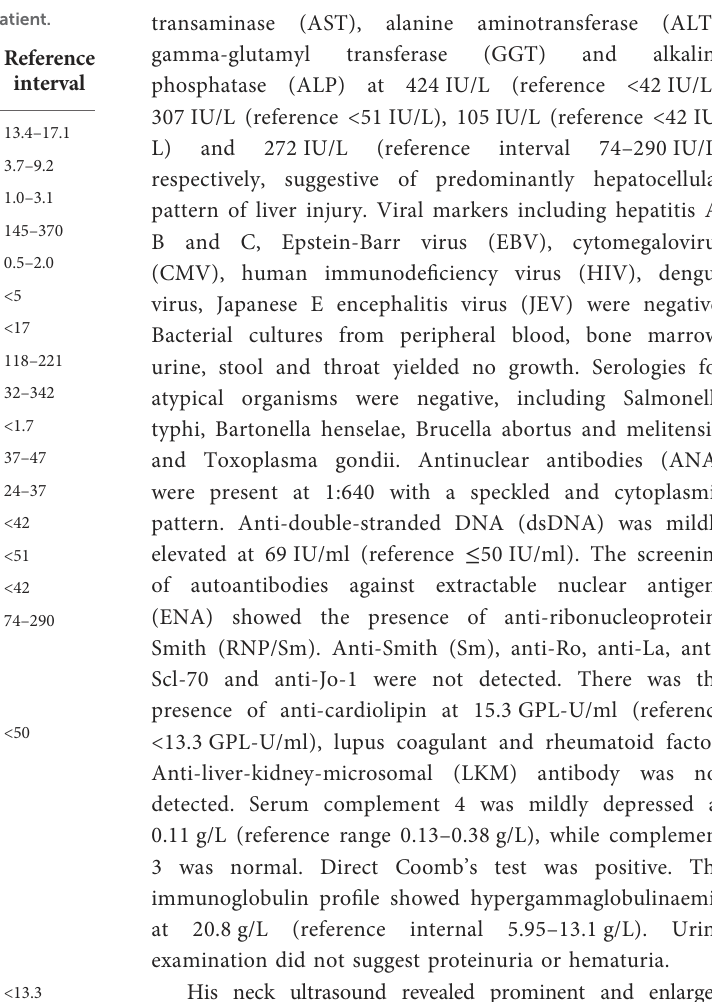
TABLE 1 A table illustrating the laboratory values of the